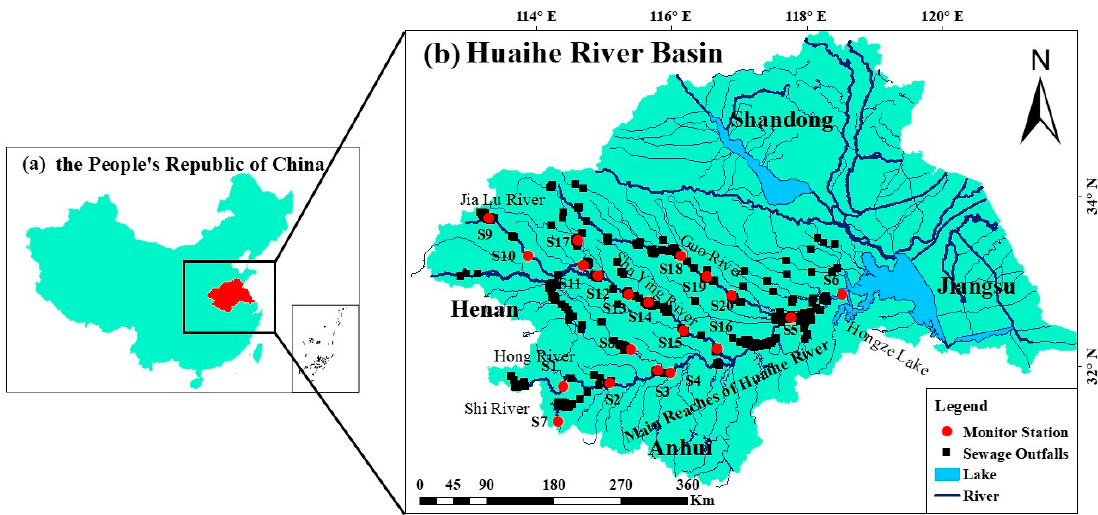
Figure 1. ( a ) The map of the People’s Republic of China. The red part is the location of the Huaihe River Basin (HRB). ( b ) The locations of monitor stations and sewage outfalls in the HRB.